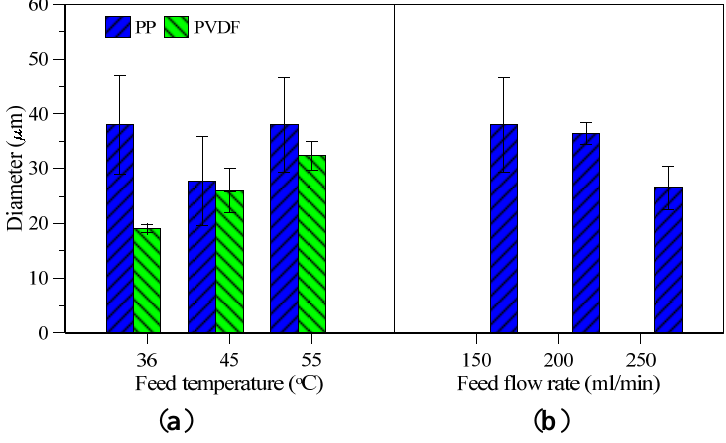
Figure 8. Mean diameter of the produced crystals at different feed temperatures and feed flow rates (( a , b )